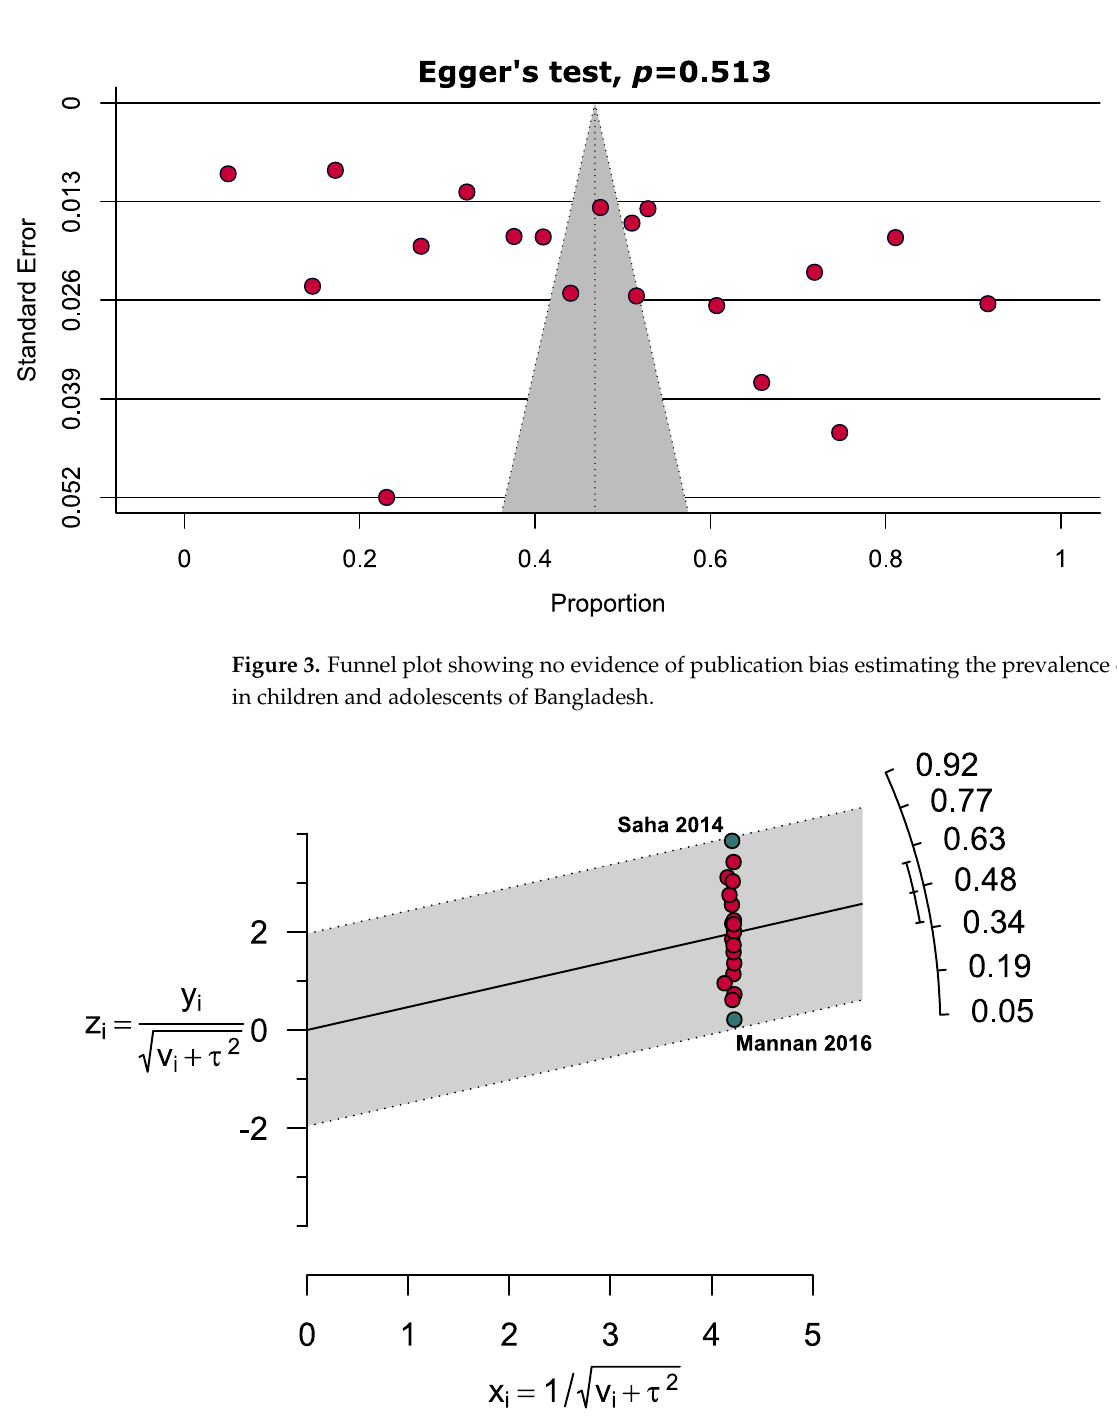
Figure 4. Galbraith plot representing two outlier studies estimating the prevalence of anemia in children and adolescents of Bangladesh.